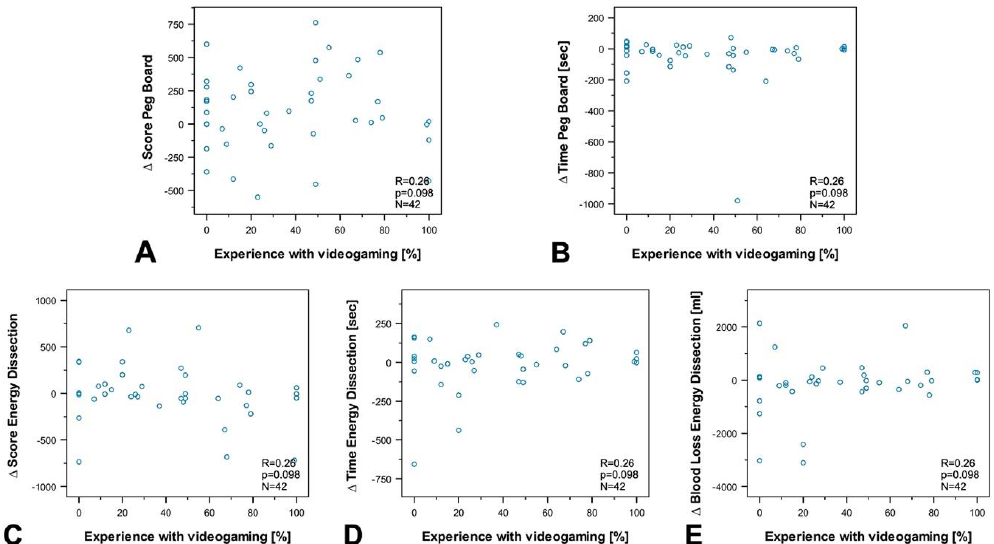
Figure 8. Correlation analysis between experience in video games, and ( A ) ∆ Final Score in Peg Board ( B ) ∆ Time to complete Peg Board, ( C ) Final Score Energy Dissection, ( D ) ∆ Time to complete Energy Dissection, and ( E ) ∆ Blood Loss Energy Dissection. No significant correlation was registered for any of the values (correlation coefficient: R, statistical significance: p, number: N).